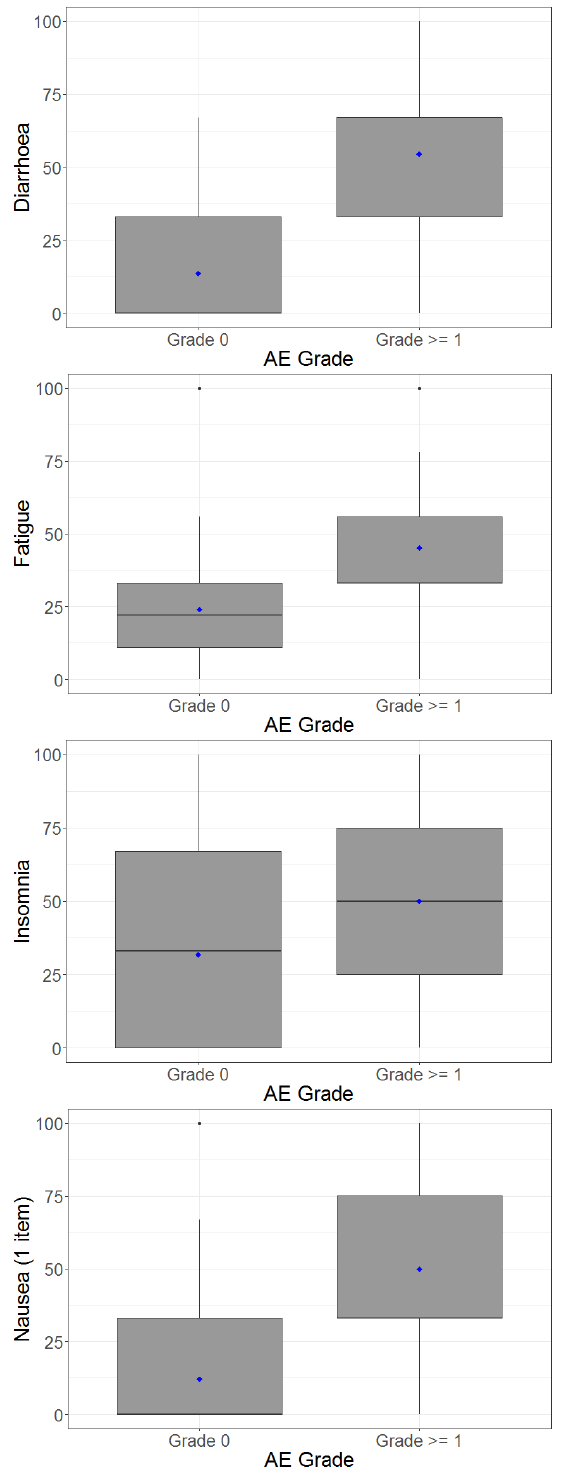
Figure 3. Figure 3. Cont.